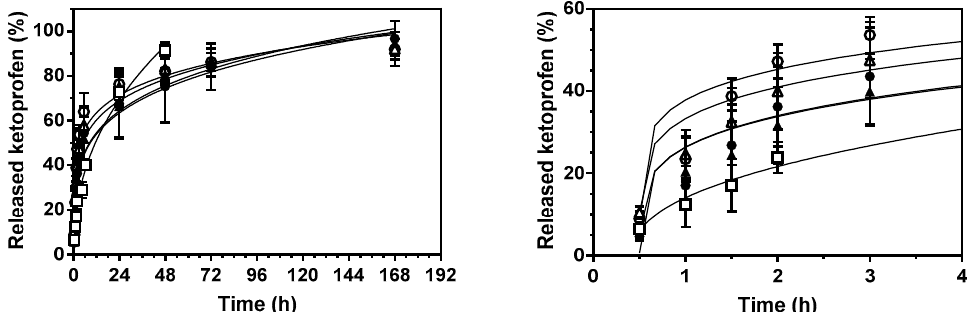
Figure 5. Ketoprofen release from PCL-based scaffolds in PBS pH 7.4 at 37 ◦ C and 60 rpm during 7 days ( left ) and close up of the profiles during the first hours ( right ). Lines correspond to the fitting of the experimental data to the Korsmeyer-Peppas with lag time drug release model (Equation (2)). Legend: PCL(5K)0BA (white squares), PCL(5K)50BA (black triangles), PCL(10K)50BA (white triangles), PCL(5K)75BA (black circles), and PCL(10K)75BA (white circles).